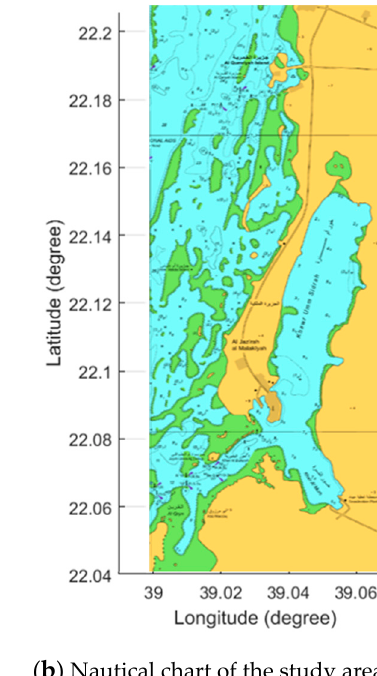
( a ) NIR-green-blue color-infrared–like image of Level-1C product for the study area. Figure 4. NIR-green-blue color-infrared–like images of Level-1C product and nautical chart of the study area.